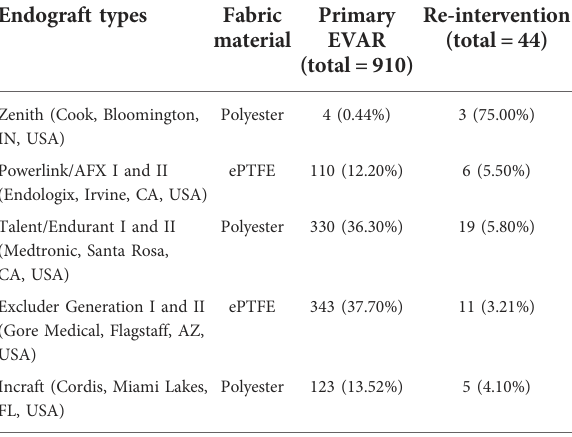
TABLE 3 Stent-graft employed during the primary endovascular aneurysm repair (EVAR) and those requiring